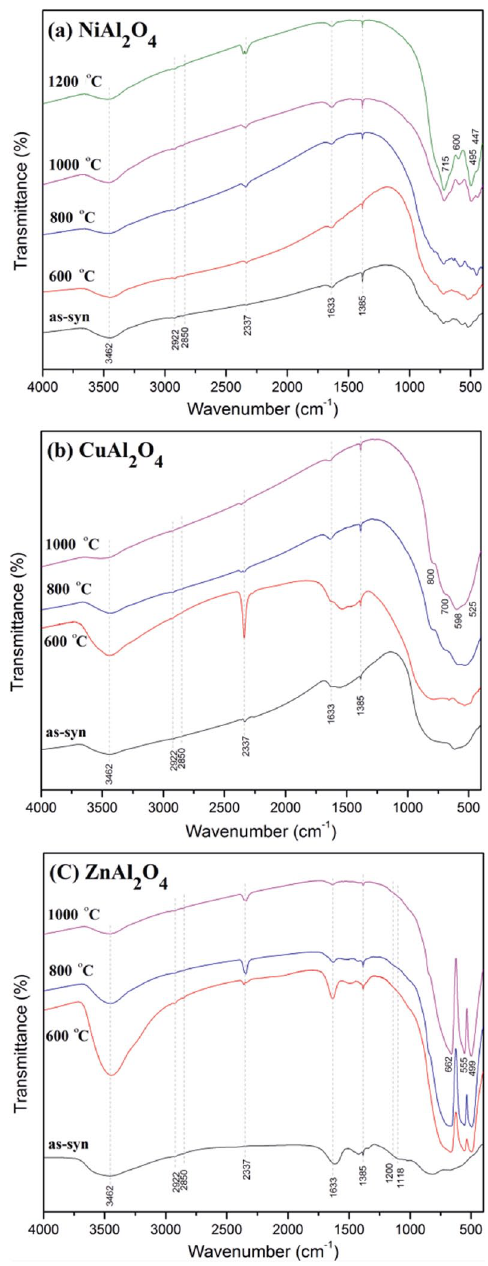
Fig. 2 FT-IR spectra of (a) NiAl 2 O 4 , (b) CuAl 2 O 4 , and (c) ZnAl 2 O 4 powders calcined at different